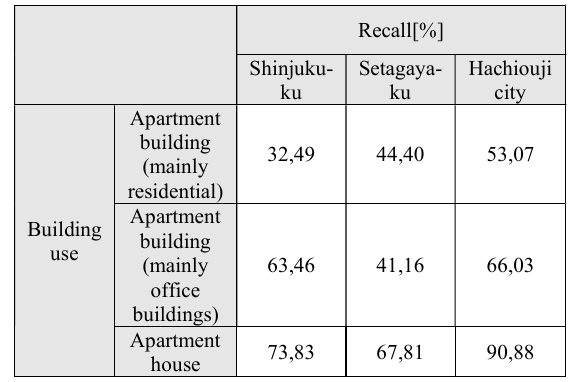
Table 10 . Recall per building